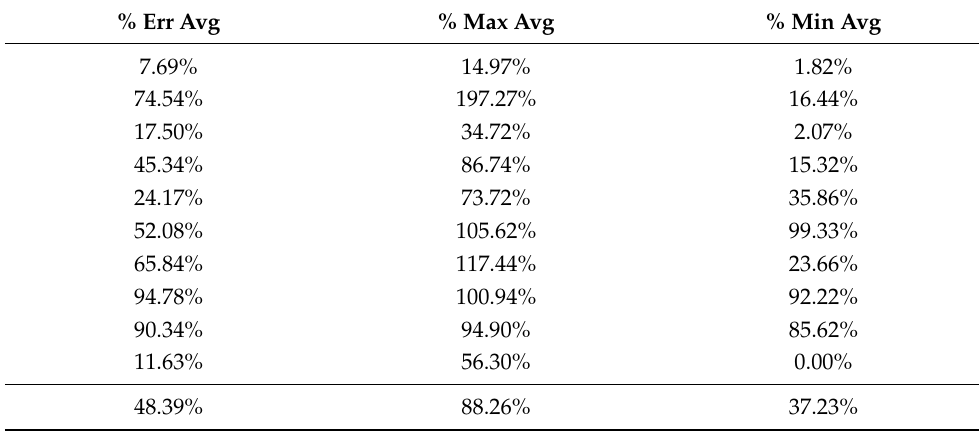
Table A88. Set 2, trials 1–10 data (actual PR value).